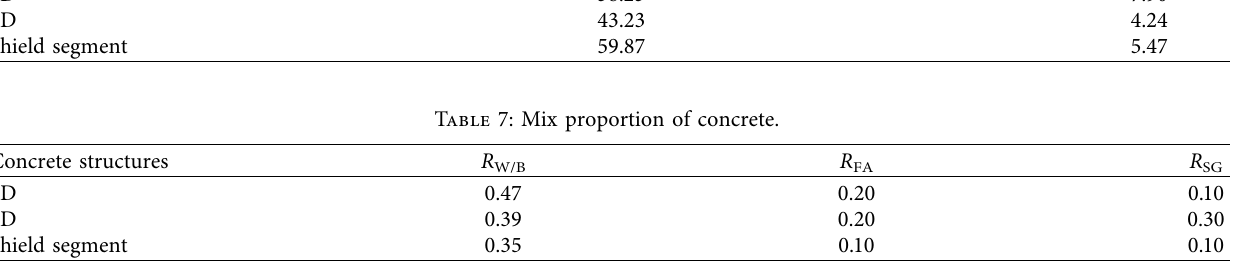
Table 6: Te required average compressive strength and chloride difusion coefcient of concrete. Concrete structures